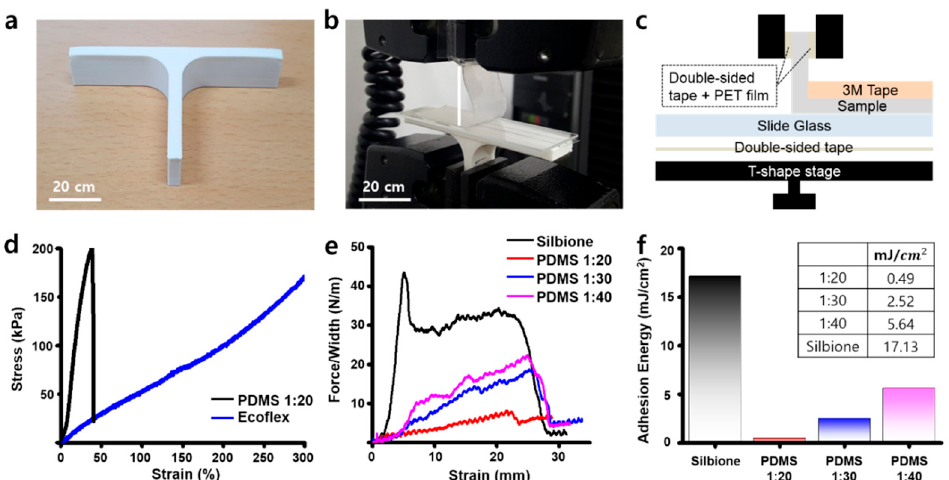
Figure 3. Mechanical characterizations of the patch components. ( a ) 3D-printed T-shape stage for the adhesion test. ( b ) The adhesion test using T-shape stage and tensile machine. ( c ) The components of the adhesion test system. ( d ) The stress–strain curve of substrate materials. ( e ) The stress–strain curve of adhesives. ( f ) The adhesion energy calculation results of adhesives. Inset: the adhesion energy of them.